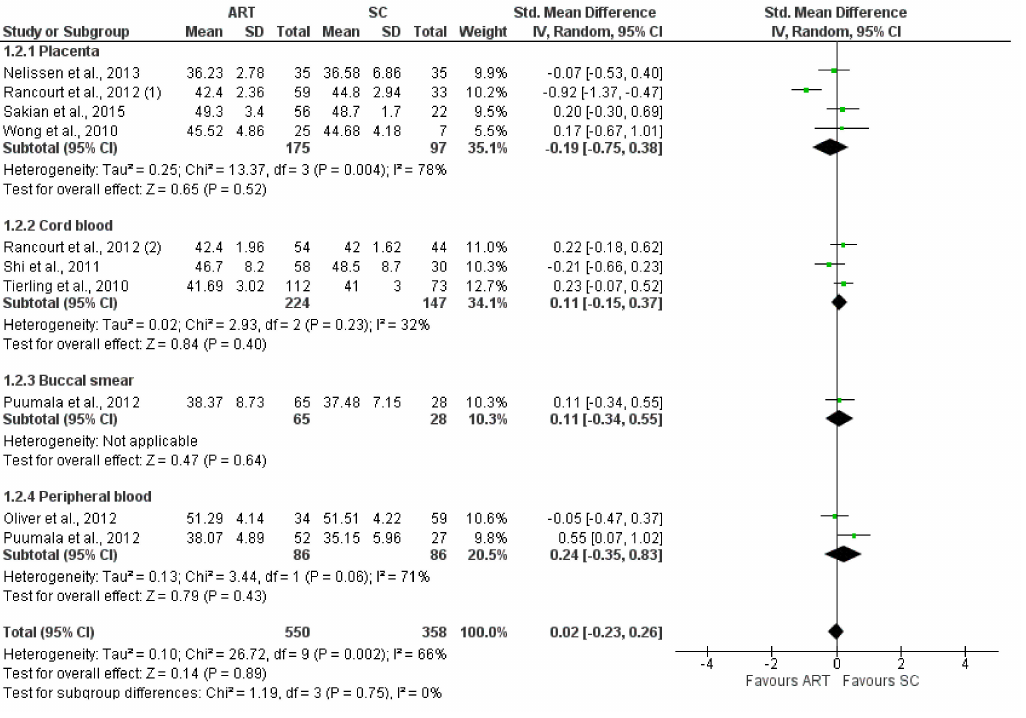
Figure 3. Methylation levels of H19 CTCF6 [52,55,58,59,61,63,66,71]. ART, assisted reproductive technique; SC, spontaneous